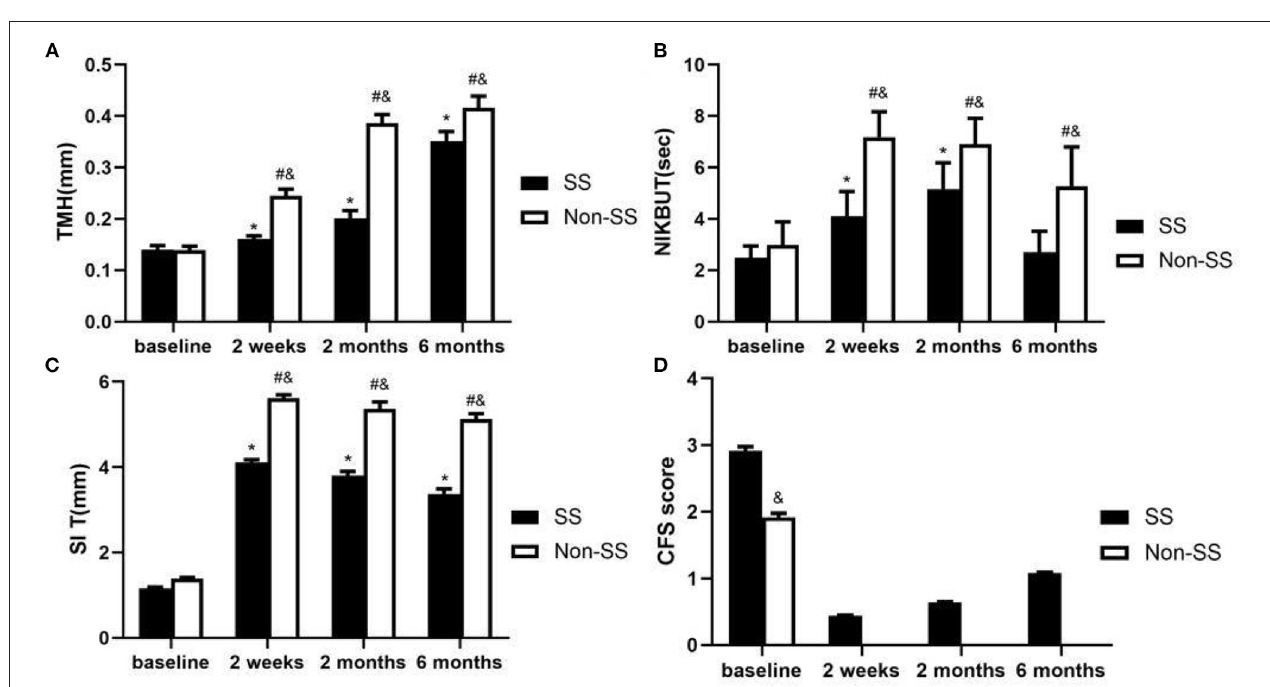
FIGURE 1 | Ocular surface parameter changes were observed in baseline, 2 weeks, 2 and 6 months after punctal plugs insertion. (A) Change in TMH (mm). After treatment, a significantly larger TMH was found in non-SS group comparing with SS group at every visit (all p < 0.05). In both groups, the TMH was improved at every visit compared to baseline (all p < 0.01). (B) Change in NIKBUT (sec). Non-SS group had a significantly longer BUT than that in the SS group at every visit. Compared with the baseline, there was statistically significant increase in NIKBUT at every visit in non-SS patients ( p < 0.01, respectively) and in SS patients NIKBUT was improved at 2 weeks and 2 months ( p < 0.01, respectively). (C) Change in SI T (mm). A significantly larger SI T was found in non-SS group comparing with SS group at every visit (all p < 0.01). The SI T score was improved at every visit compared to baseline in both groups (all p < 0.01). (D) Change in CFS score. There was